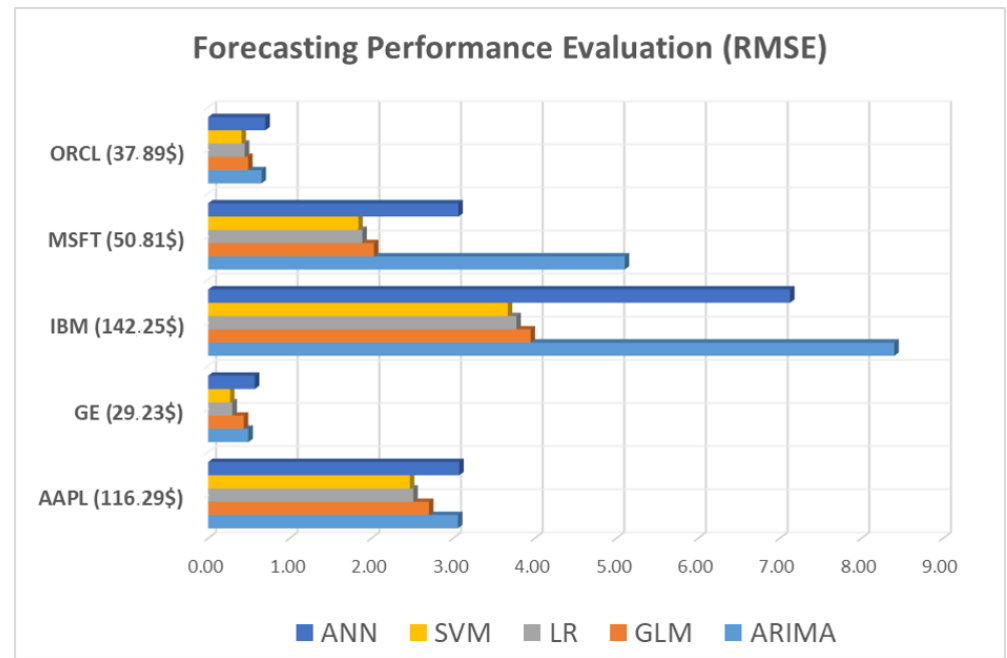
Figure 7. SVM and LR are outperforming all other models, with ARIMA and ANN having significantly worse performance.